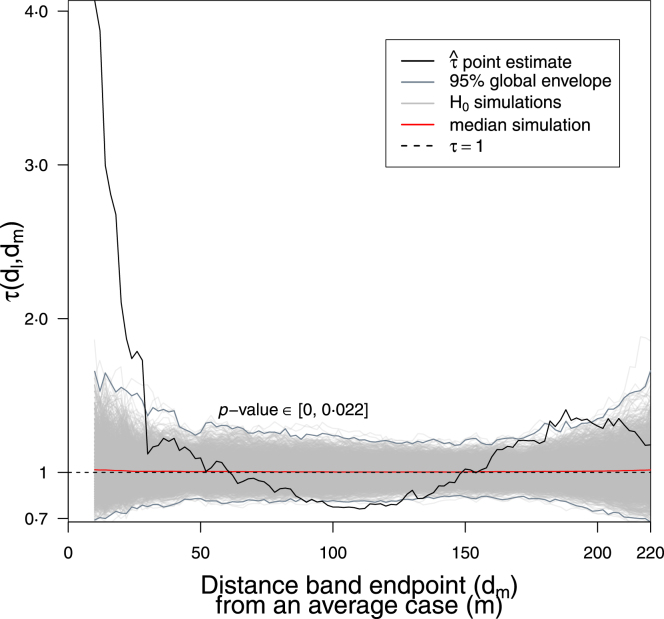
Graphical hypothesis testing: Global envelope test, ‘extreme rank’ type, two-sided at 95% significance level using 2500 simulations of the null hypothesis (H0: no spatiotemporal clustering nor inhibition, i.e. τ=1), p-value ∈[0,0⋅022]. Note there is a region where τˆ just exits the global envelope lower bound (suggesting inhibition at ∼100 m) as well as the obvious departures above the upper bound (suggesting clustering at close distances and ∼190 m). We are confident that we are simulating H0 well because the median simulation stays close to τ=1 throughout. Distance band set ≔{[0,10),[0,12),[0,14),…,[0,50),[2,52),[4,54),…,[170,220)m}.